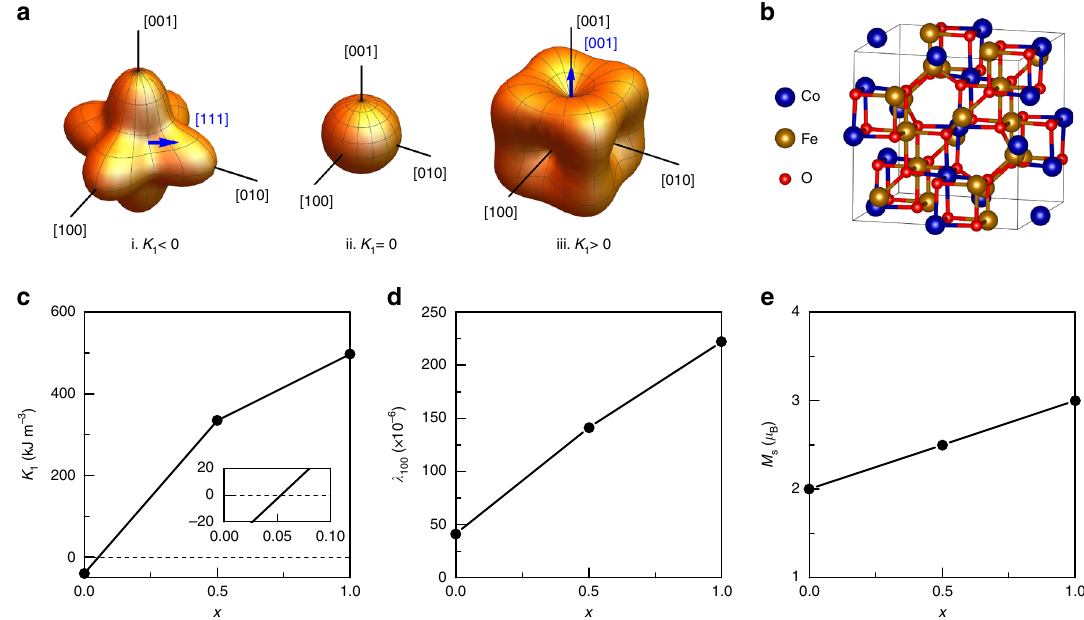
Fig. 4 First principles calculation of NiFe 2 O 4 -CoFe 2 O 4 solid solution. a Energy surfaces for cubic anisotropy with (i) K 1 < 0, (ii) K 1 = 0, (iii) K 1 > 0. Blue arrow shows the direction of easy axis. b Cation distribution of Fe (brown) and Co/Ni (blue) on the B-sites of the spinel structure (space groups Imma ) used in the calculations. c Magnetocrystalline anisotropy K 1 of Ni 1- x Co x Fe 2 O 4 ; d Magnetostriction λ 100 of Ni 1- x Co x Fe 2 O 4 ; e Saturation magnetization per molecule (in